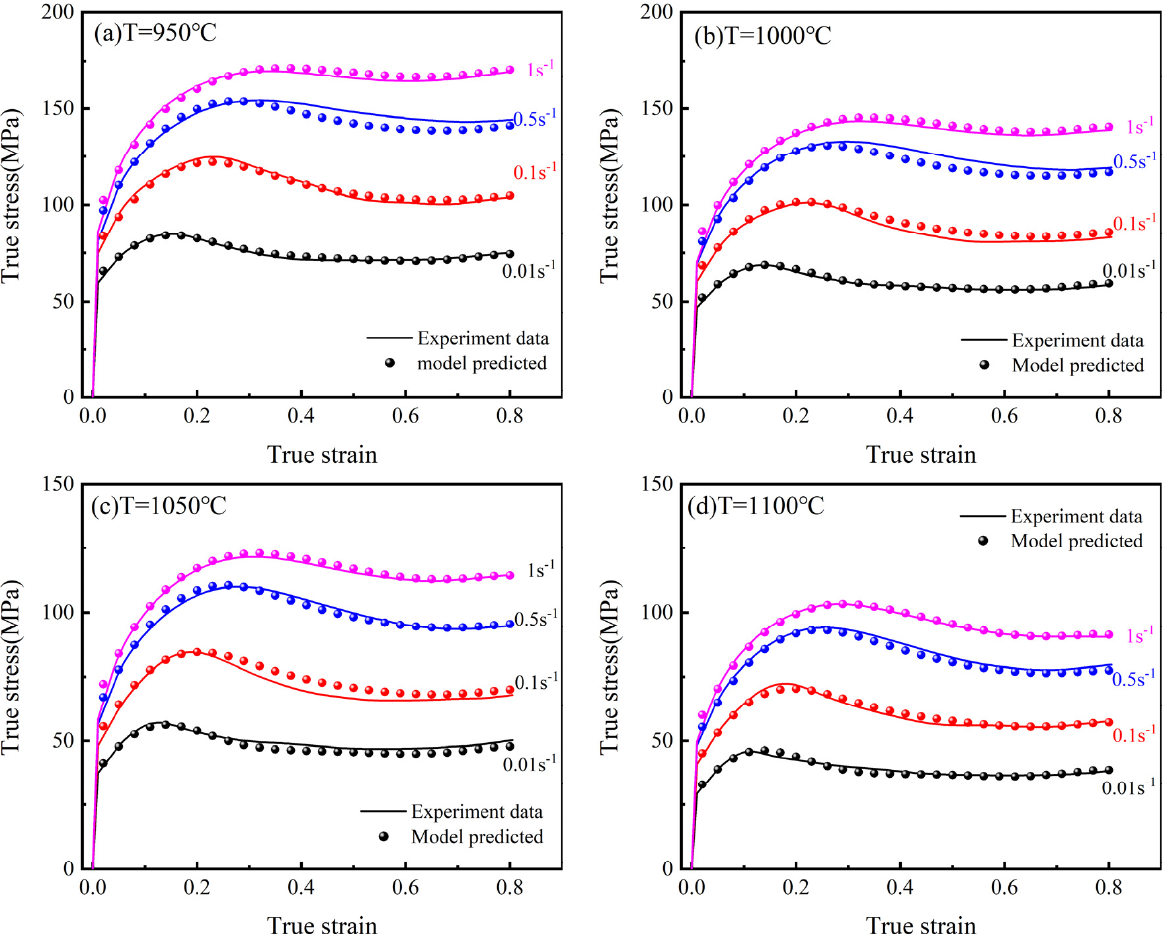
Figure 12. Modified Arrhenius modeling results from the experimental data at different temperatures and strain rates. ( a ) T = 950 °C; ( b ) T = 1000 °C; ( c ) T = 1050 °C; ( d ) T = 1100 °C. In order to evaluate the accuracy of the constitutive models, the absolute relative error (ARE), the average absolute relative error (AARE), and the correlation coefficient (R 2 ) are used as essential references. ARE ， AARE, and R 2 values can be calculated by: − 𝜎 (cid:4708)𝜎 (cid:2915)(cid:2934)(cid:2926) (cid:2887)(cid:2889) ARE(%) =